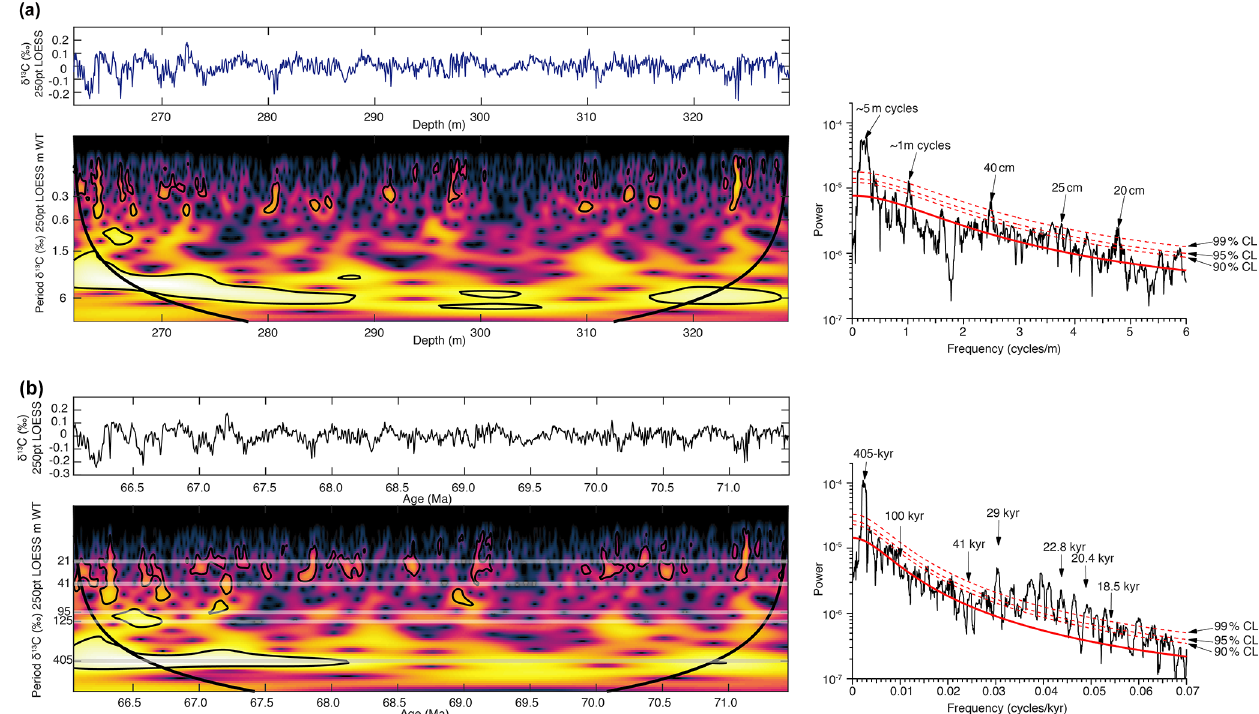
Figure 2. (a) Bulk carbonate δ 13 C by depth (m) shown with 250-point LOESS smoothing and wavelet analysis (Torrence and Compo, 1998; Grinsted et al., 2004) and the multi-taper method (MTM) shown for spectral analysis. (b) δ 13 C by age (Ma) shown with 250-point LOESS smoothing and wavelet analysis and MTM shown for spectral analysis. CL indicates confidence level. Note age is increasing from the left to